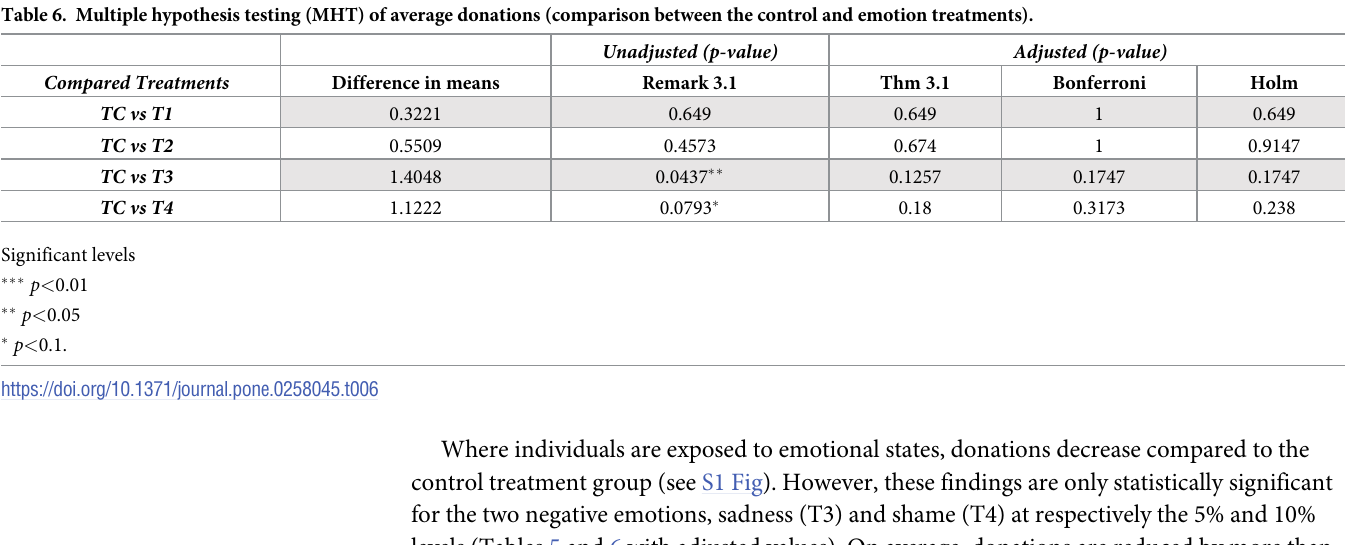
NEP-Low NEP scale score < 3.8